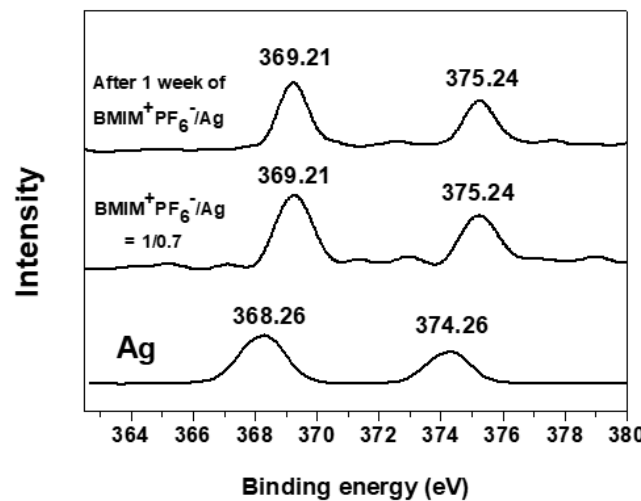
Figure 5. Binding energy of Ag in 1/0.7 BMIM + PF 6 − /Ag composites after preparation and after 1 week.